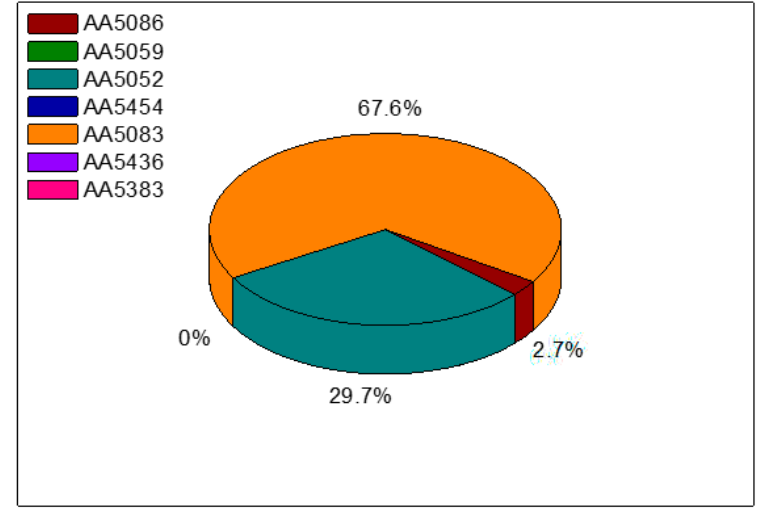
Figure 1. Base material used to fabricate AAMMCS using 5xxx series marine grade.